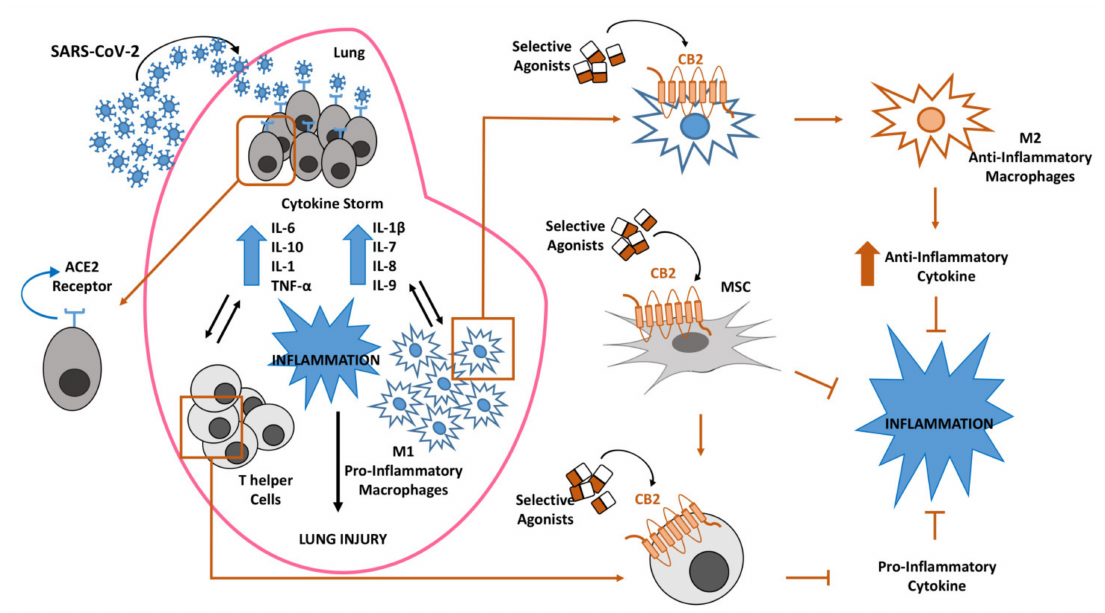
Figure 1. Inflammatory response in lung after coronavirus (SARS-CoV-2) infection. Lung susceptibility to SARS-CoV-2 infection depends on viral spike proteins specificity for angiotensin-converting enzyme 2 (ACE2) receptors on alveolar epithelial cells. This interaction leads to hyperinflammation sustained by cytokine storm, increase of pro-inflammatory M1 macrophages and T-helper cells, all associated in a vicious circle in which each event enhances the alteration of the other ones. The selective stimulation of Cannabinoid Receptor type 2 (CB2) receptors on macrophages, T-helper cells and mesenchymal stromal cells (MSCs) could be proposed to contain the inflammatory state in COVID-19